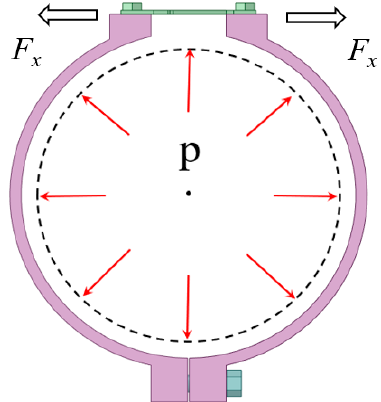
Figure 5. State of pipeline under internal pressure.